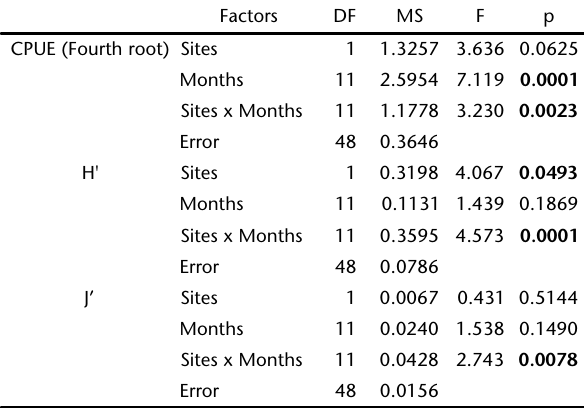
Table IV. Variance analysis (ANOVA) of the CPUE, diversity index (H’) and equity index (J’) between Sites, Months and the interaction between these factors. (DF) Degrees of Freedom, (MS) mean squares, (F) value of F for the test. P values in bold indicate statistical significance (p <